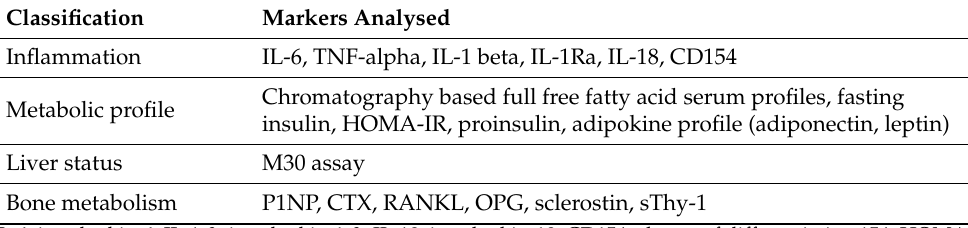
Table 3. Biomarkers assessed in METABOLyx